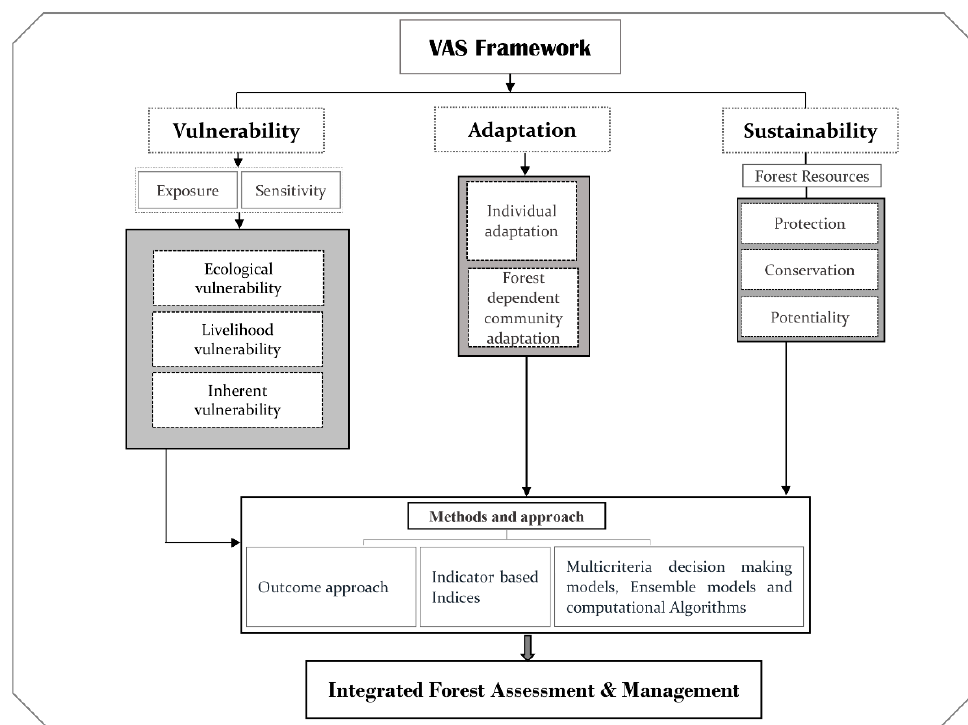
Figure 6. Proposed frameworks for future research.